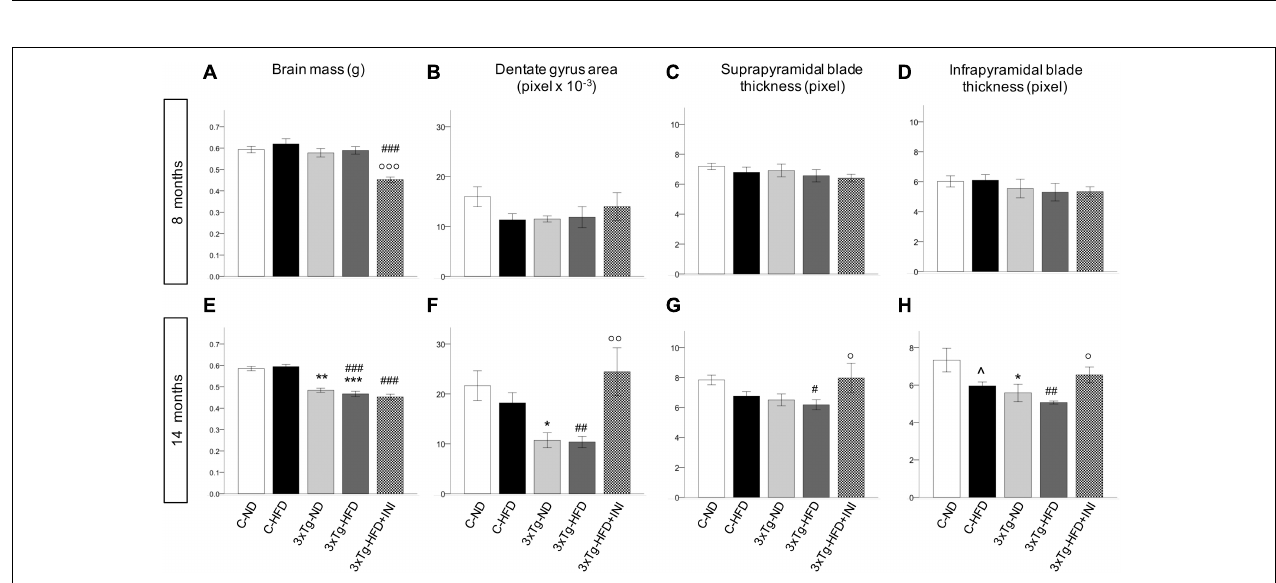
FIGURE 7 | Cerebral morphologicalcharacterization in 8 (top) and 14 (bottom) months old mice, including brain mass (A,E) , area of dentate gyrus (B,F) , and thickness of suprapyramidal (C,G) and infrapyramidal blades (D,H) , as measured in coronal brain sections stained with haematoxylin-eosin. Sample sizes are given in Table 1 . ∗ p < 0.05 or less ( ∗∗ , ∗∗∗ ) ND-ND and HFD-HFD (between strains), ∧ p < 0.05 HFD vs. ND (within-strain), # p < 0.05 or less ( ## , ### ) vs. ND control group (reference group), ◦ p < 0.05 or less ( ◦◦ , ◦◦◦ ) for treated 3 × Tg-HFD + INI vs. untreated 3 × Tg-HFD.